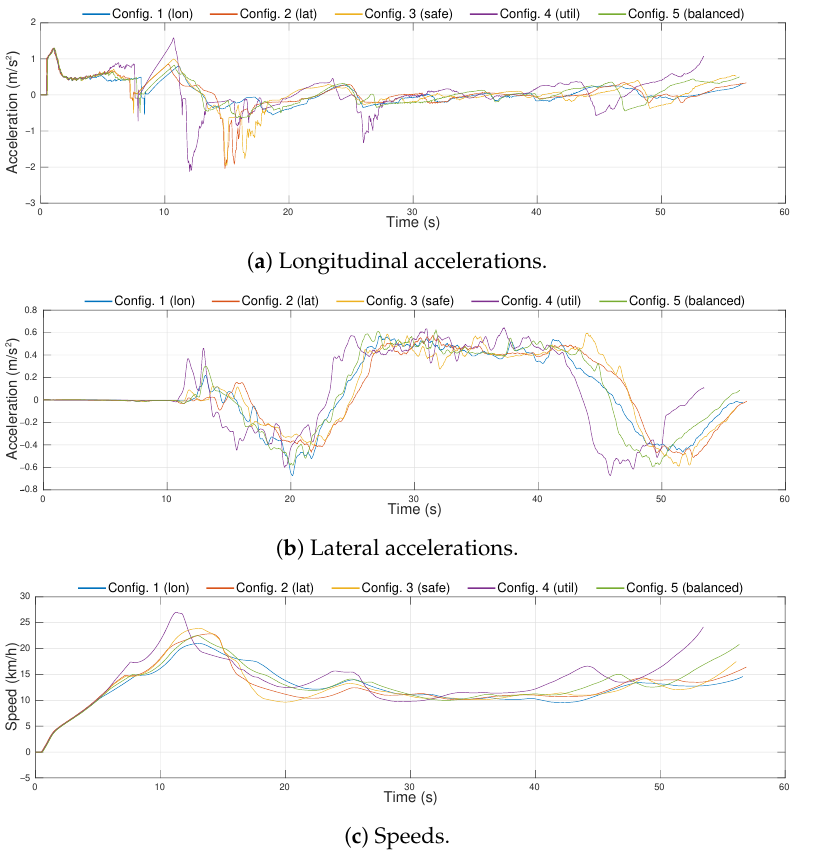
Figure 17. Acceleration and speed profiles for the different configurations executed in the simula- tion environment.